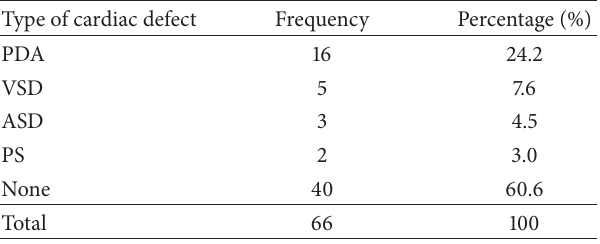
Table 2: Types and frequencies of congenital heart defects. Type of cardiac